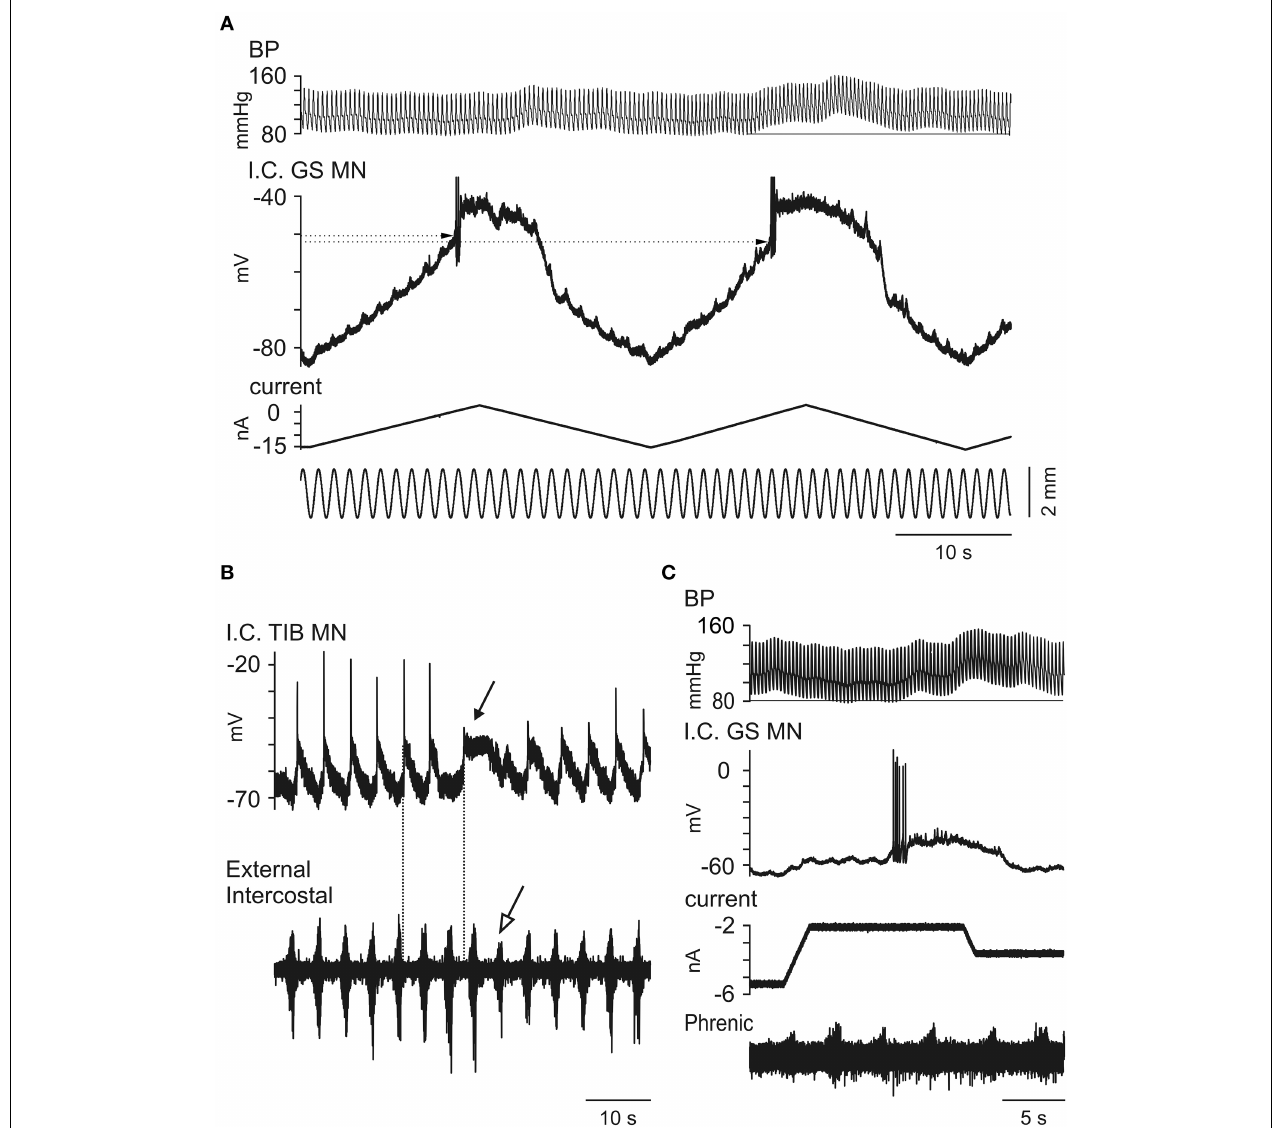
FIGURE 9 | Observations on changes in intrinsic motoneuronal properties in relation to Mayer waves. (A) . Recurrent small depolarizations were evoked by small sinusoidal stretches of the triceps surae while triangular current injections were used to initiate plateau potentials. Note that at the beginning of the Mayer wave (at the second triangular increase of current) the threshold for evoking the plateau potential (dotted lines) is lower than during a lower-blood pressure period (i.e., during the first ramp). (B) CRDP recorded in a TIB MN. In this case the Mayer wave is inferred by the